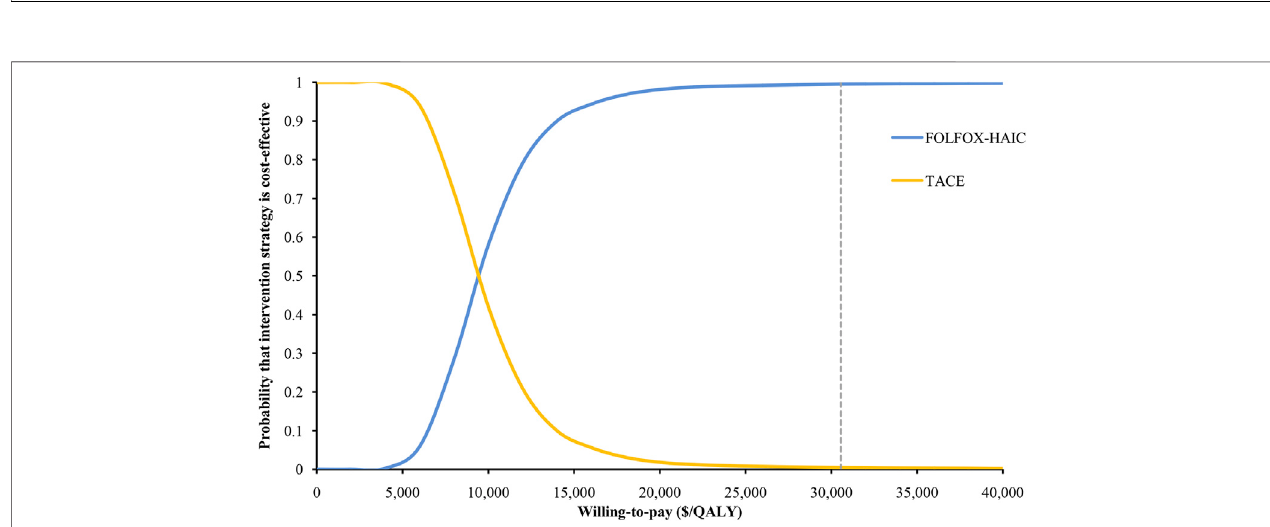
FIGURE 3 | | Cost-effectiveness acceptability curves for the FOLFOX-HAIC strategy compared to the TACE strategy. This plot represents the results of a probabilisticsensitivityanalysisshowingtheprobabilityofcost-effectivenessoftheFOLFOX-HAICstrategyversustheTACEstrategyinlargeunresectablehepatocellular carcinoma.TACE,transarterialchemoembolization;FOLFOX-HAIC,hepaticarterialinfusionchemotherapywithinfusional fl uorouracil,leucovorin, andoxaliplatin;QALY, quality-adjusted life year.